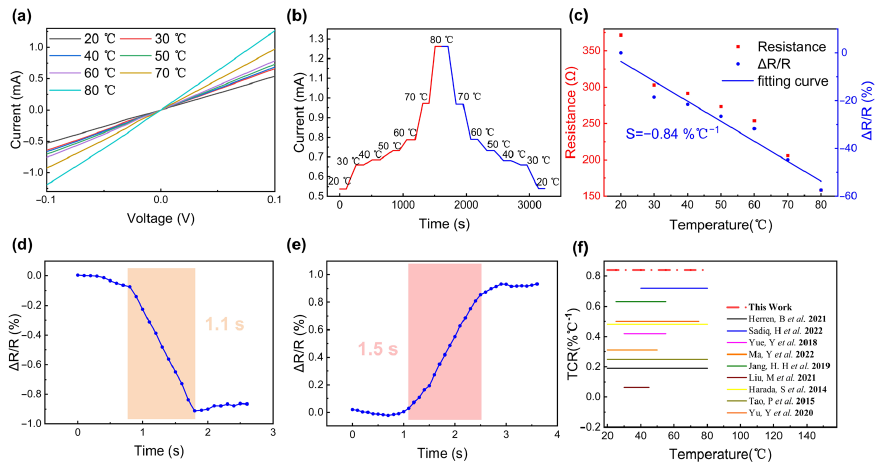
Figure 4. The temperature−sensing properties of the CNT sponge wrapped in PEDOT:PSS: ( a ) the linear relationship of the I−V curves at voltages from −0.1 V to 0.1 V; ( b ) the gradient of the current increase and decrease when under a continuous temperature change; ( c ) the resistance and resistance change rate of the device over a temperature range from 20 °C to 80 °C, exhibiting a sensitivity of 0.84% °C −1 ; ( d ) the response time of the composite sponge when the temperature rises; ( e ) the response time of the composite sponge when temperature drops; ( f ) comparison with other studies [13,14,17,20,26,29,30–32]. The temperature sensitivity is determined by the variation of resistance and the applied pressure. The specific calculation formula is as follows: